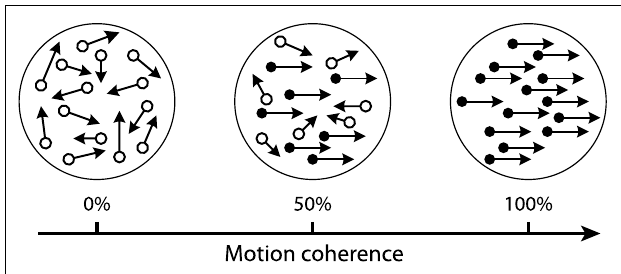
FIGURE 1 | Schematic diagram of the RDM stimulus with different motion coherence levels. In each frame a proportion of the dots (solid dots) are repositioned with fixed spatial offset, indicating the coherent motion direction, and the rest of the dots (open dots) are repositioned randomly. More detailed specification of the stimulus is available in Britten et al.